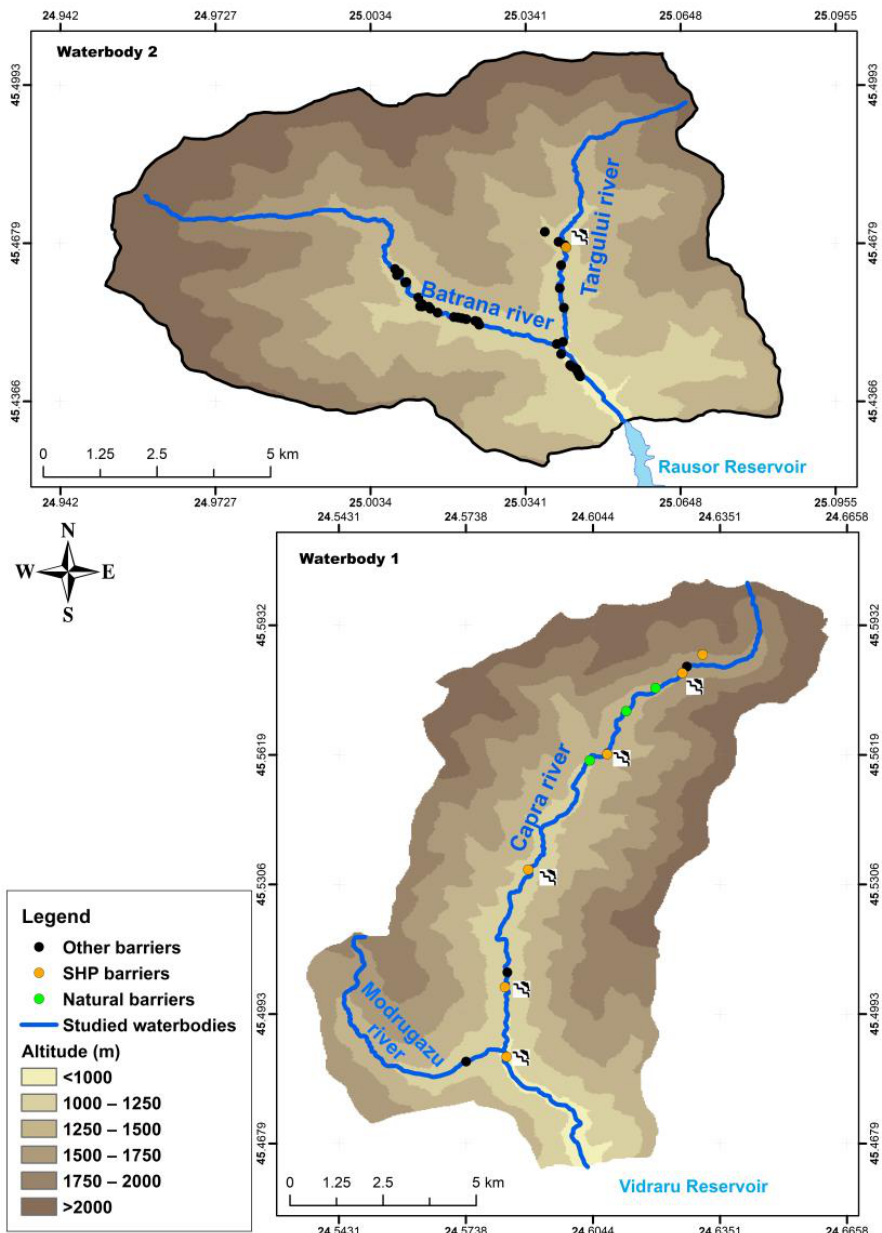
Figure 6. The location of the barriers within the study areas.